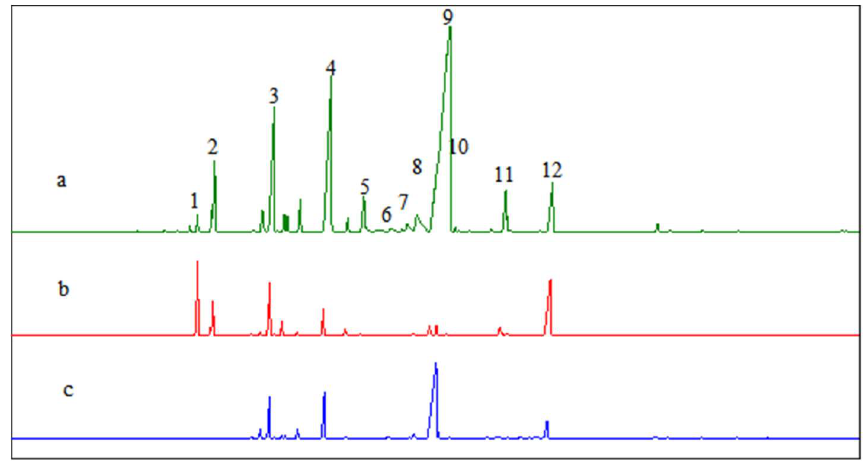
Figure 4. GC chromatograms of the reaction products: ( a ) with water in the starting material; ( b ) without water in the starting material; and ( c ) with terpineol as the starting material. Note: 1. α-pinene; 2. camphene; 3. limonene; 4. iso-terpinene; 5. fenchyl alcohol; 6. β-terpineol; 7. (iso)borneol; 8. 4-terpineol; 9. α-terpineol; 10. γ-terpineol; 11. bornyl acetate; 12. terpinyl acetate.